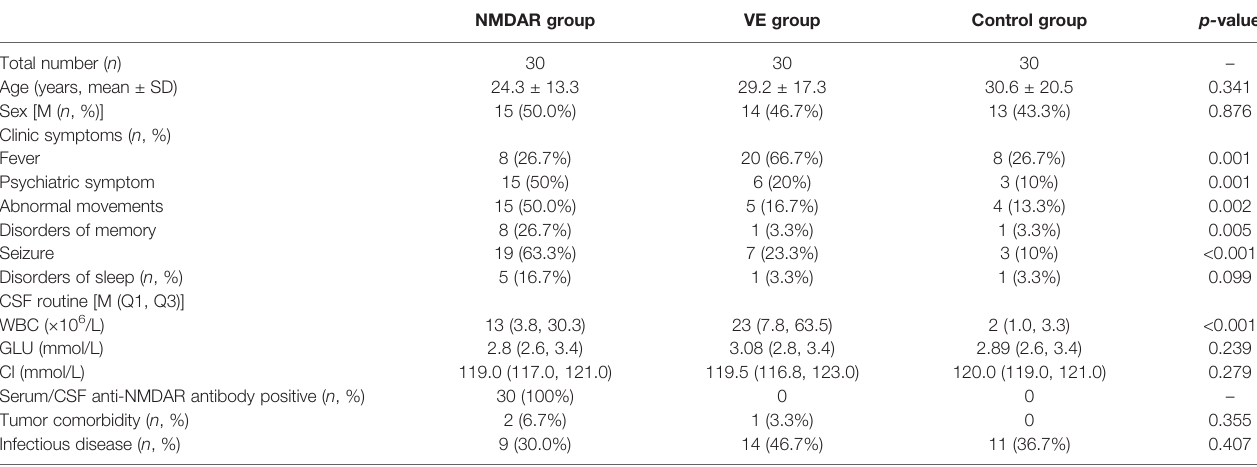
TABLE 2 | Clinical characteristics of patients in three